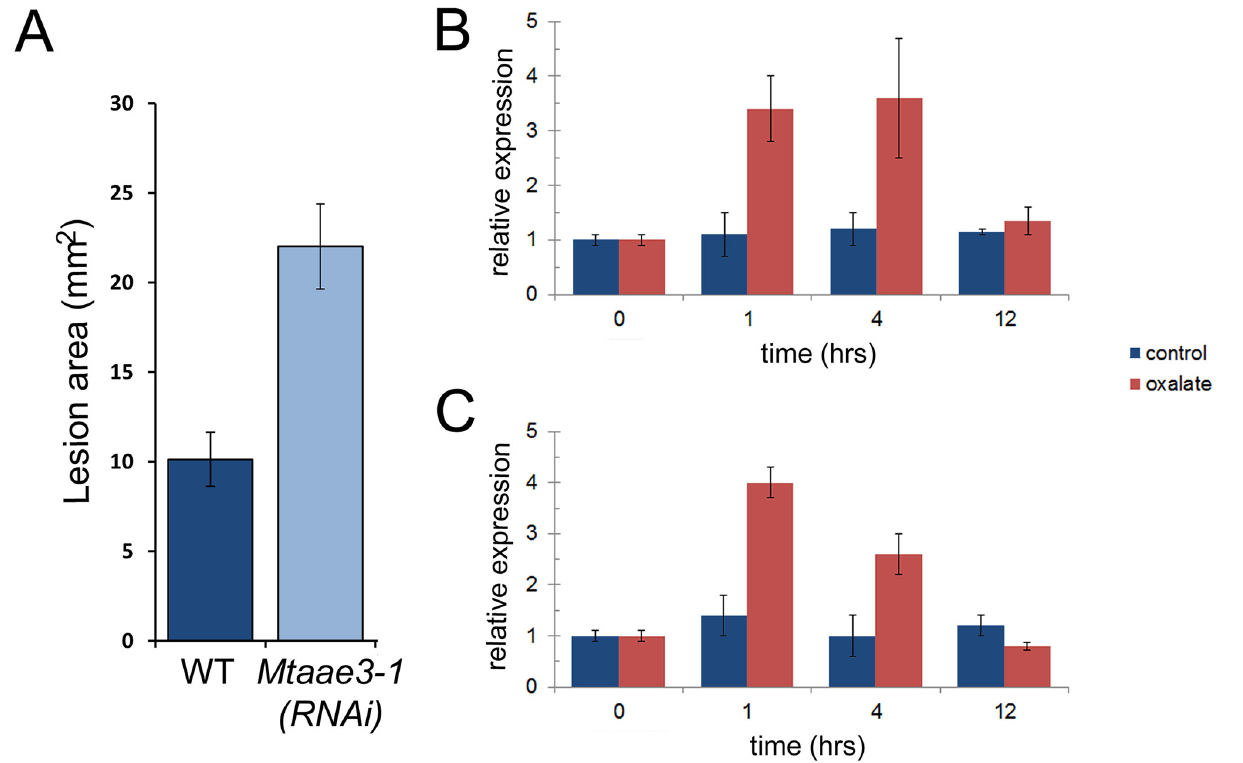
Fig 5. Assessment of Mt AAE3 in protection against oxalate-secreting phytopathogens. (A) Measurements of fungal spread in leaves of WT and Mtaae3-1 knock-down line inoculated with S . sclerotiorum . Lesion areas were measured 48 h after inoculation. Data are mean ± SE. (B) Quantitative RT-PCR of MtAAE3 expression in roots from control and oxalate-treated plants over time. (C) Quantitative RT-PCR of MtAAE3 expression in shoots from control and oxalate-treated plants over time. The cycle threshold values were normalized using the ubiquitin as a reference gene.